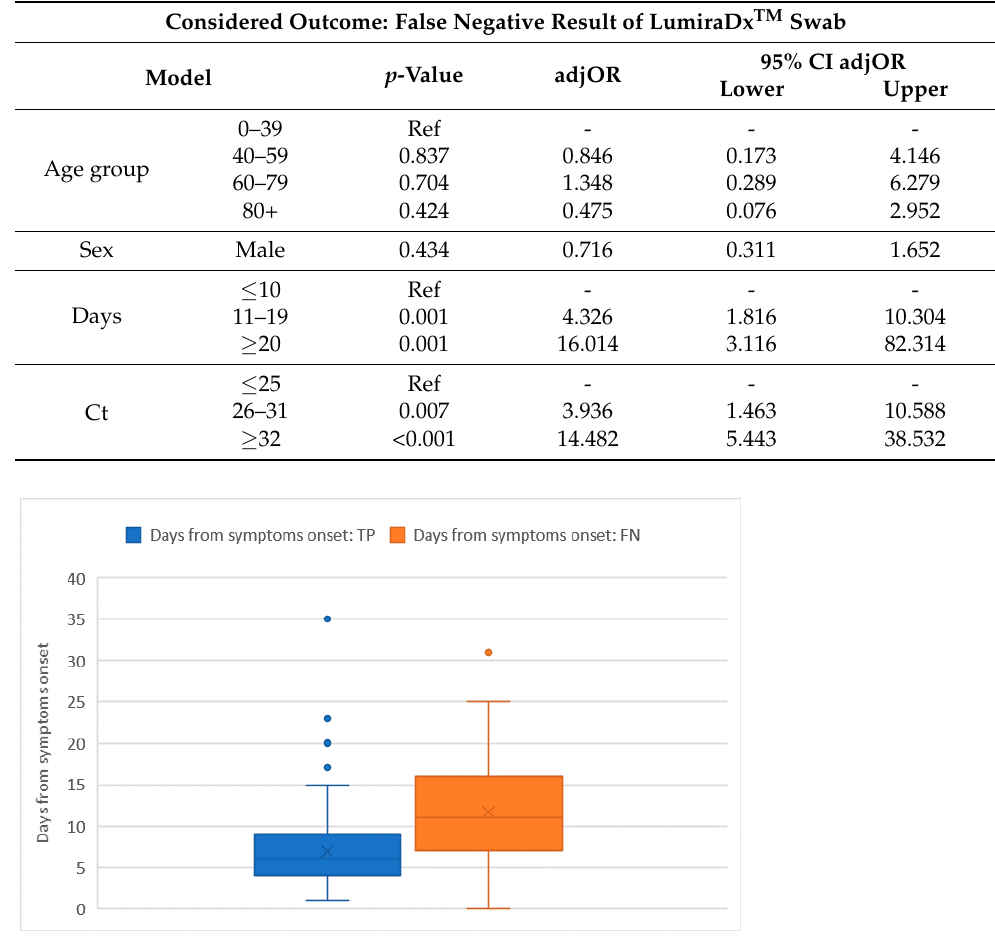
Table 3. Summary of multivariate binomial logistic regression (Nagelkerke’s R 2 = 0.388).